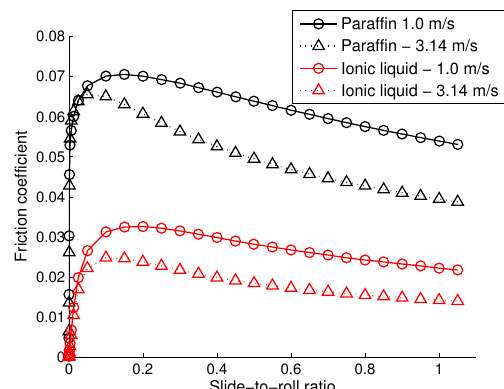
Figure 8. Friction measurements for Paraffin and [Choline] [Proline] at 40 ◦ C and 1.95 GPa. [Choline] [Proline] had a water content of slightly below 15 wt %.